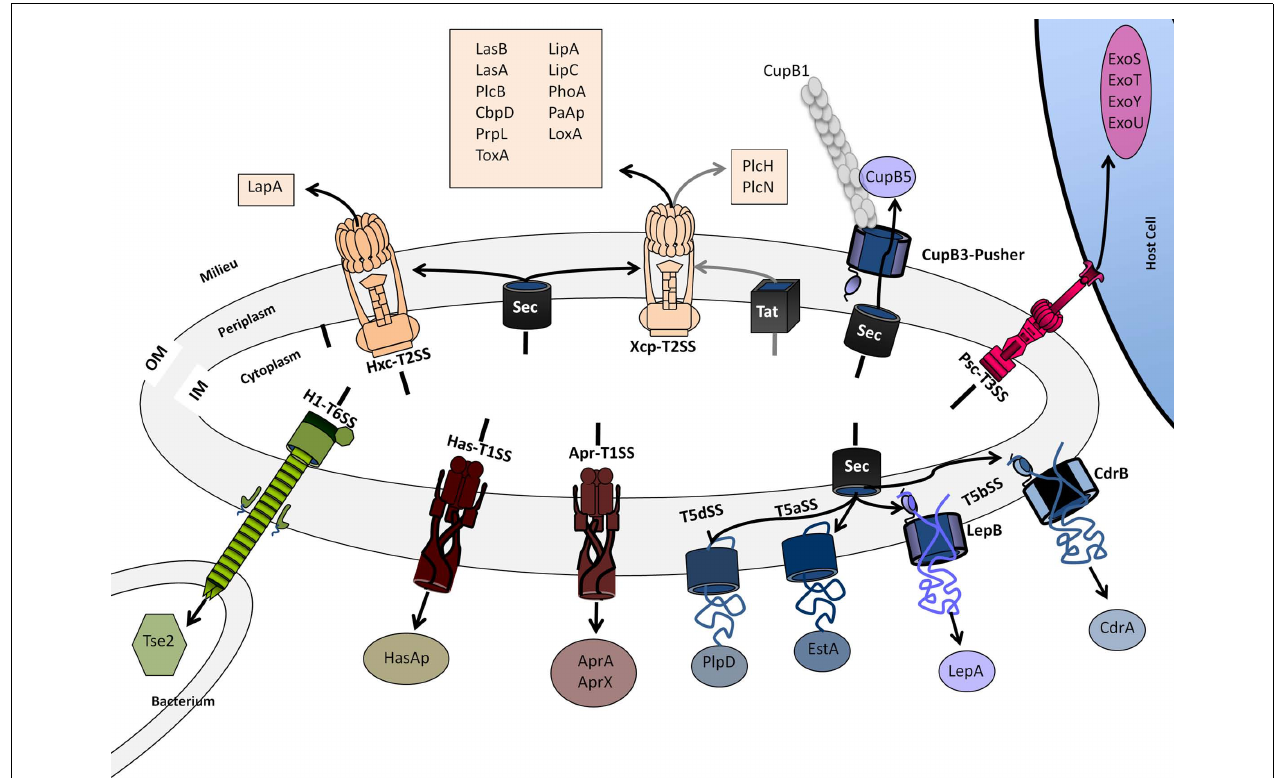
FIGURE 7 | Secretion systems in P. aeruginosa .The systems shown are discussed in the main text. For characteristics of exoproteins see also Table 1 .The design of the secretion systems is as previously presented in Bleves et al. (2010). Color code is: brown (T1SS), light Orange (T2SS), red (T3SS), blue/purple (T5SS), green